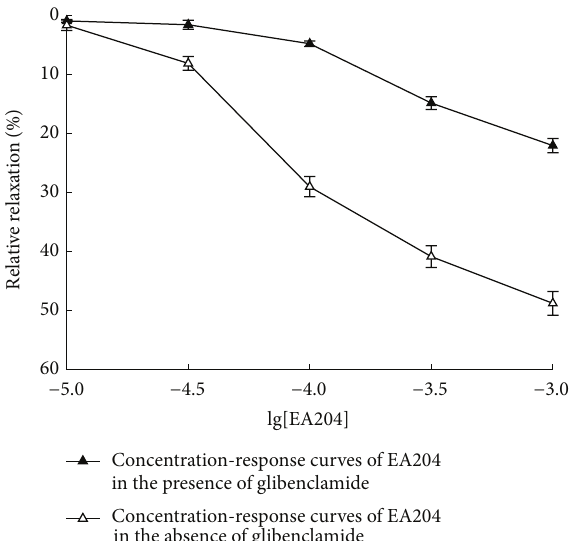
Figure 5: Cumulative concentration-response curves of EA204 in theabsenceorpresenceofglibenclamide(10 −5 M)ondenudedaortic rings of rabbits precontracted with BaCl 2 (2mg/mL). Endothelium was removed mechanically by rubbing with a steel wire. Responses are expressed as a percentage of the maximum possible relaxation, that is, relaxation back to the baseline tension. Values indicated the means ± SEM ( 𝑛 = 8 ).